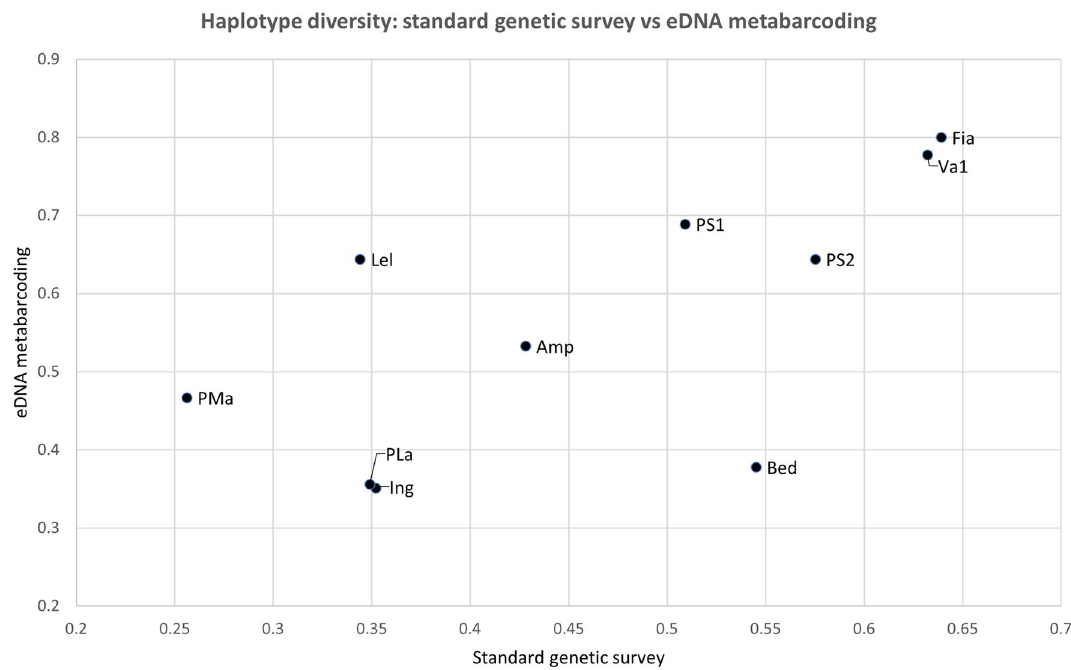
Figure 3. Scatterplot of the correlation between the haplotype diversity index values for Rana temporaria in the Province of Trento Italy, for two datasets: x-axis: standard tissue-based genetic survey 41 ; y-axis: current study (eDNA metabarcoding).